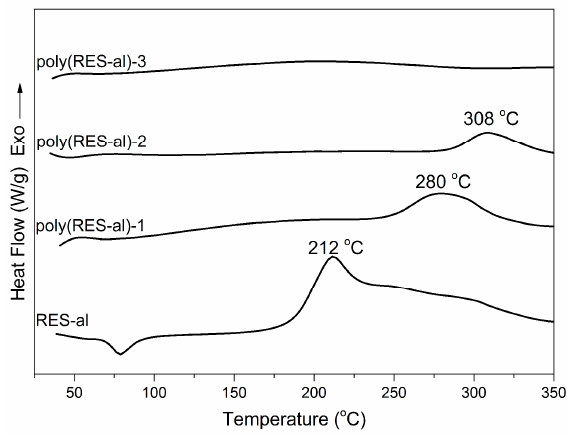
Figure 6. DSC thermograms of RES-al and its related thermosets recorded under N 2 at a heating rate of 10 °C/min.